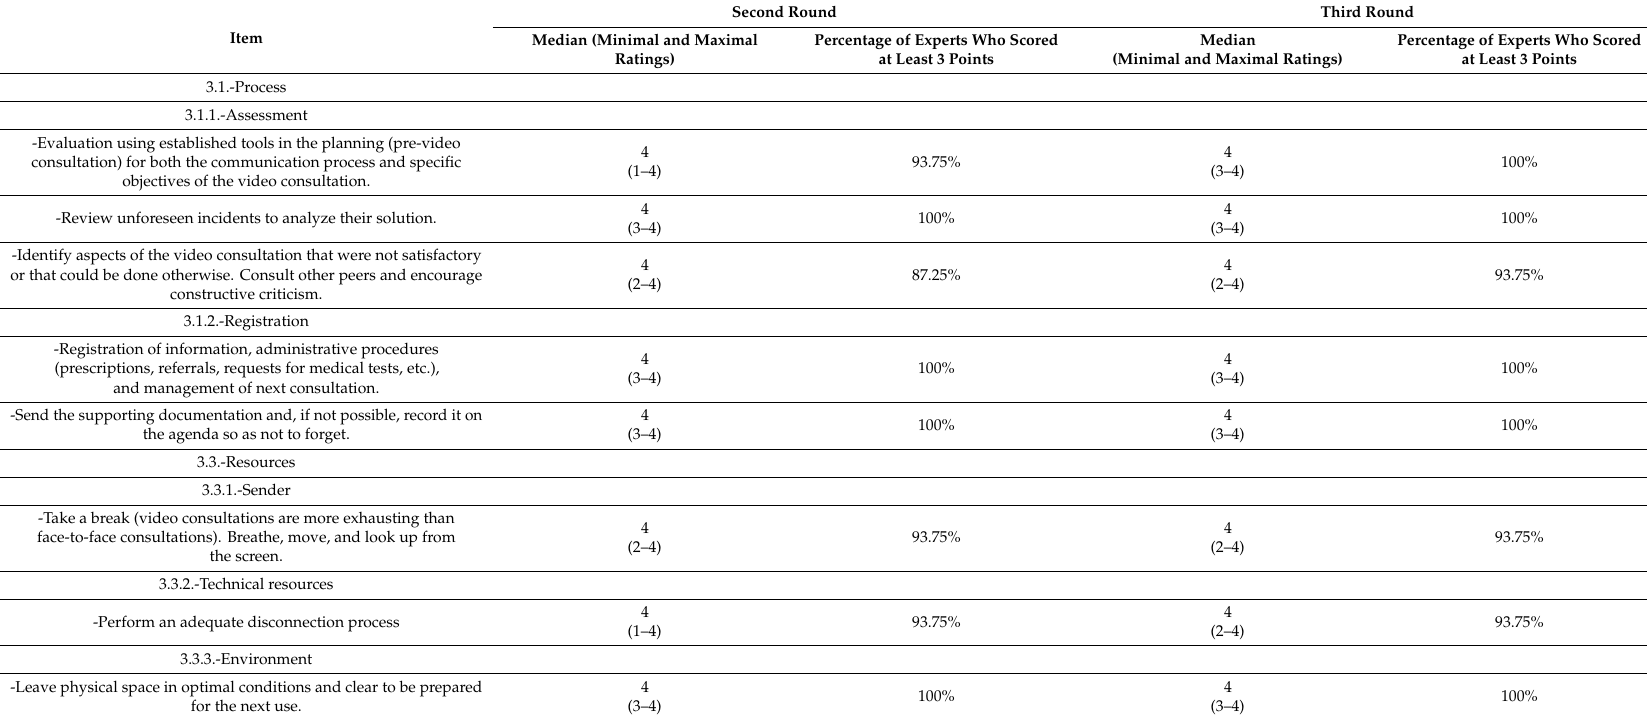
Table 4. Results of Delphi method: post-video